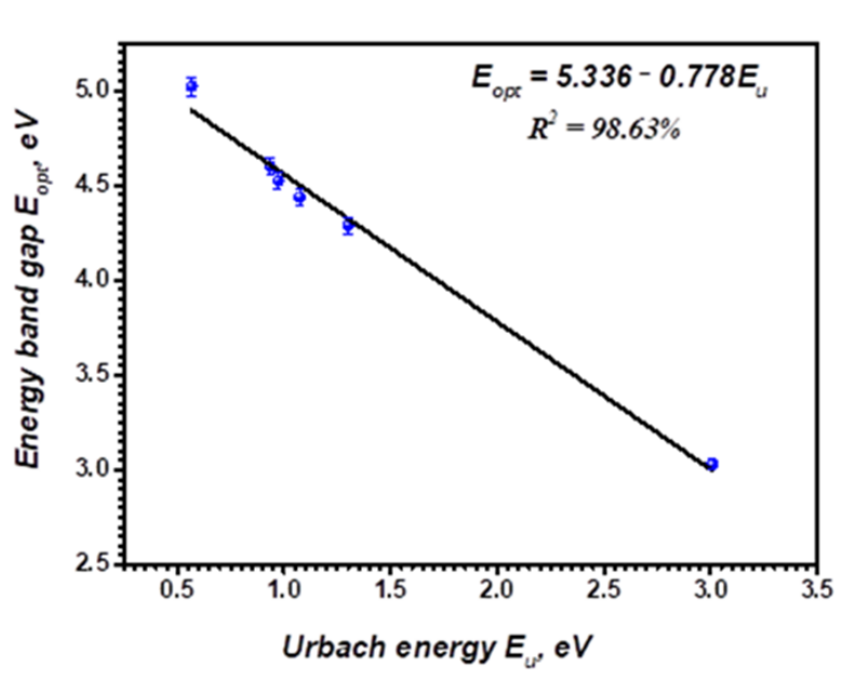
(cid:3028)(cid:3049) , vs Urbach energy, 𝐸 , of pristine (cid:3048) (cid:3042)(cid:3043)(cid:3047)